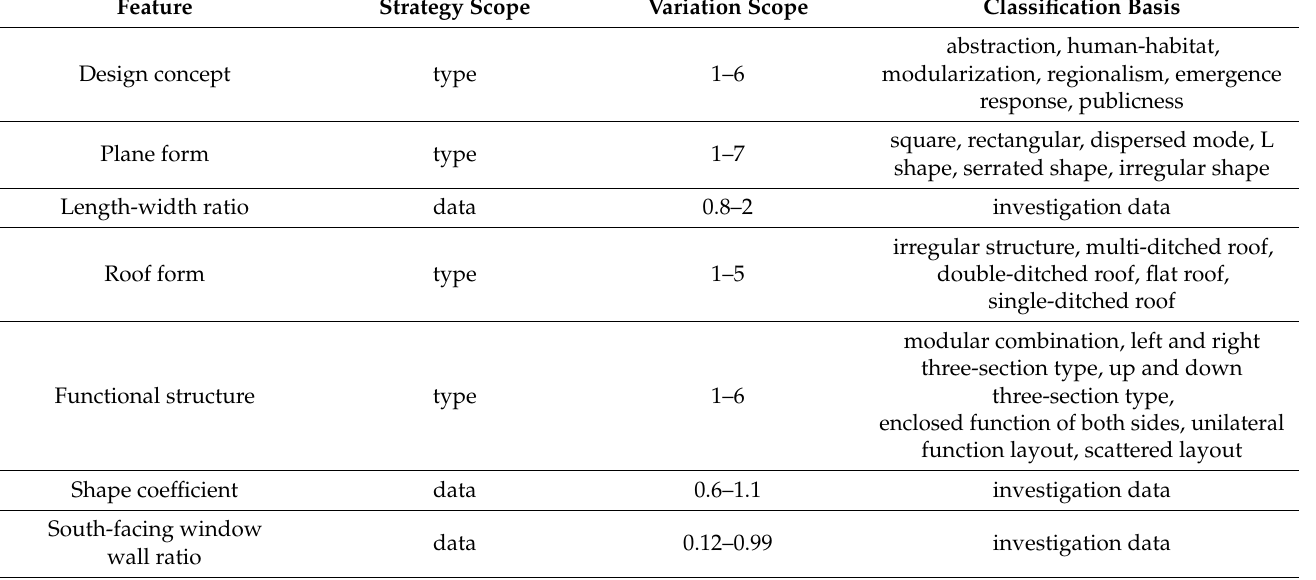
Table 11. Energy-saving design